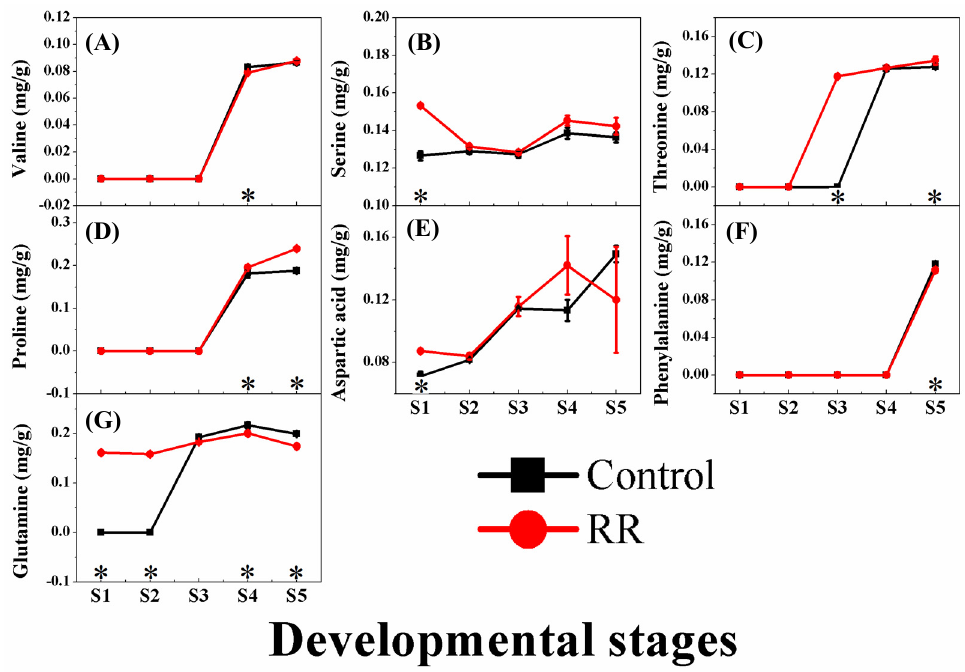
Figure 2. Effects of RR treatment on the content change of amino acids of grape berry. ( A ) Valine; ( B ) serine; ( C ) threonine; ( D ) proline; ( E ) aspartic acid; ( F ) phenylalanine; ( G ) glutamine. * indicates significant differences ( p < 0.05, n = 3).